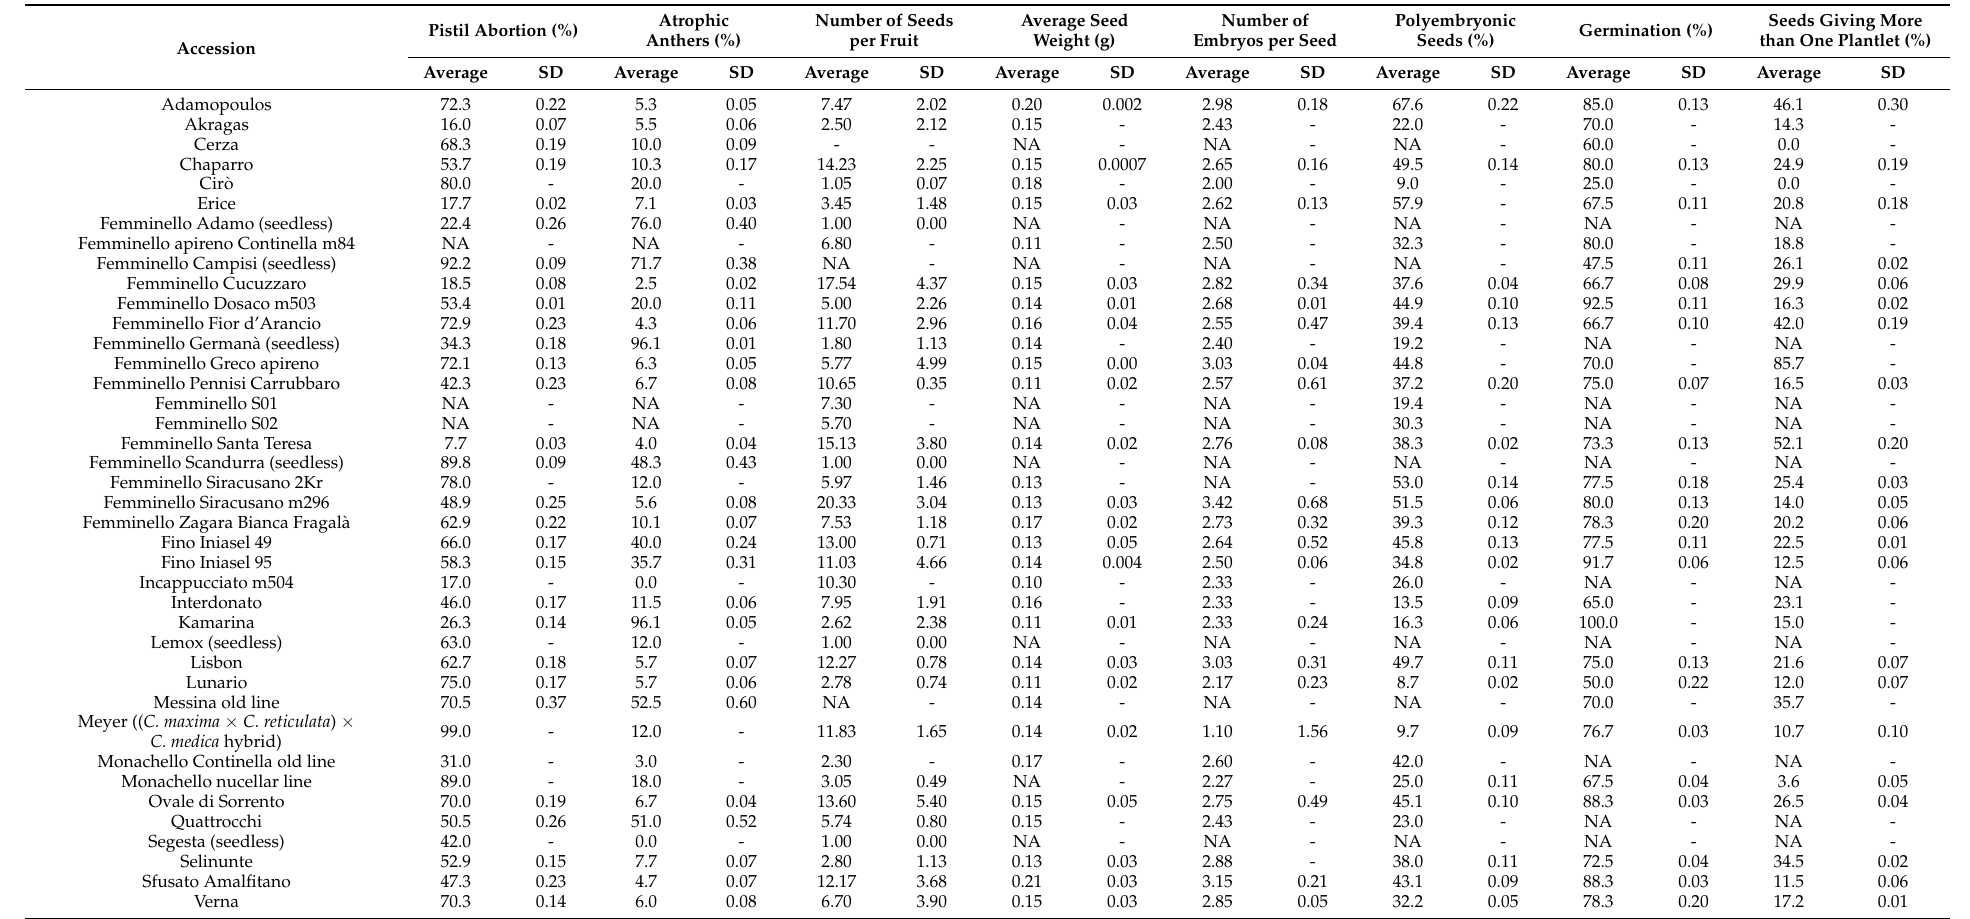
Table 1. Results of the three-year evaluation of eight traits related to reproductive biology in lemon accessions considered in the present